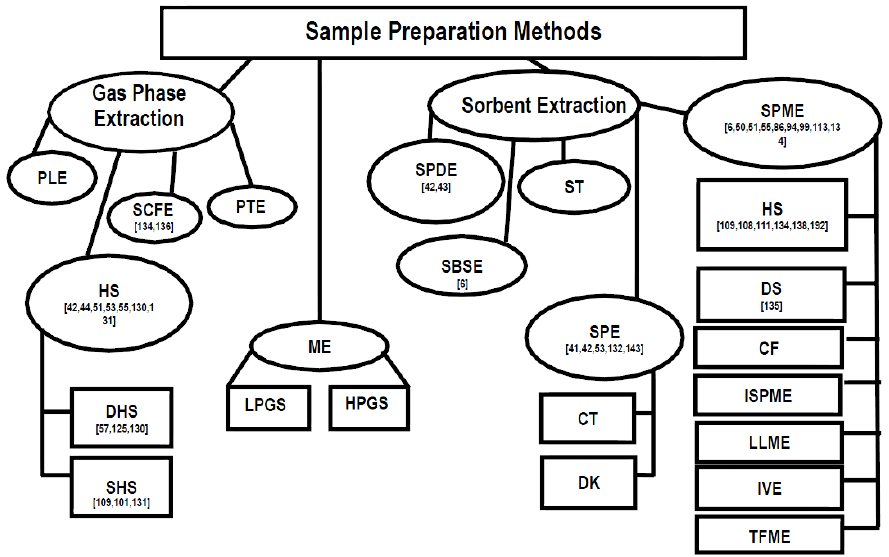
Figure 4. Summary of sampling preparation techniques with references used for chemical and sensory characterization of scent-markings in wild